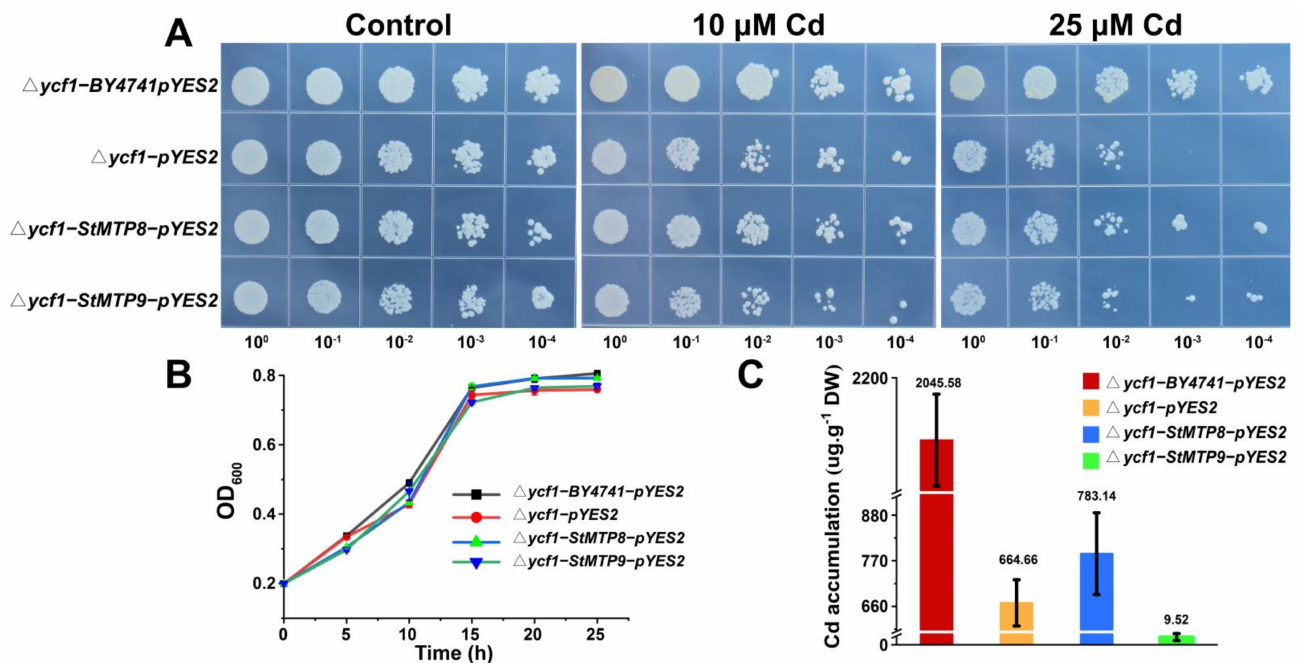
Figure 8. Functional analysis of StMTP8 and StMTP9 in the yeast cells. ( A ): ∆ ycf1 and BY4741 (control) carrying empty vectors and recombinant plasmids carrying StMTP8 and StMTP9 recombinant plasmids were grown on SG solid medium containing 0, 10, 25 µ M Cd for 3 days. ( B ): The growth status of yeast cells at different time points. Culture the yeast OD 600 to 0.2, add CdCl 2 to make the medium concentration reach 25 µ M, then take samples and measure every 5 h. ( C ): The accumulation of Cd in yeast cells. The different colored bars indicate different yeast strains, and the numbers on the bars represent the content of Cd in the